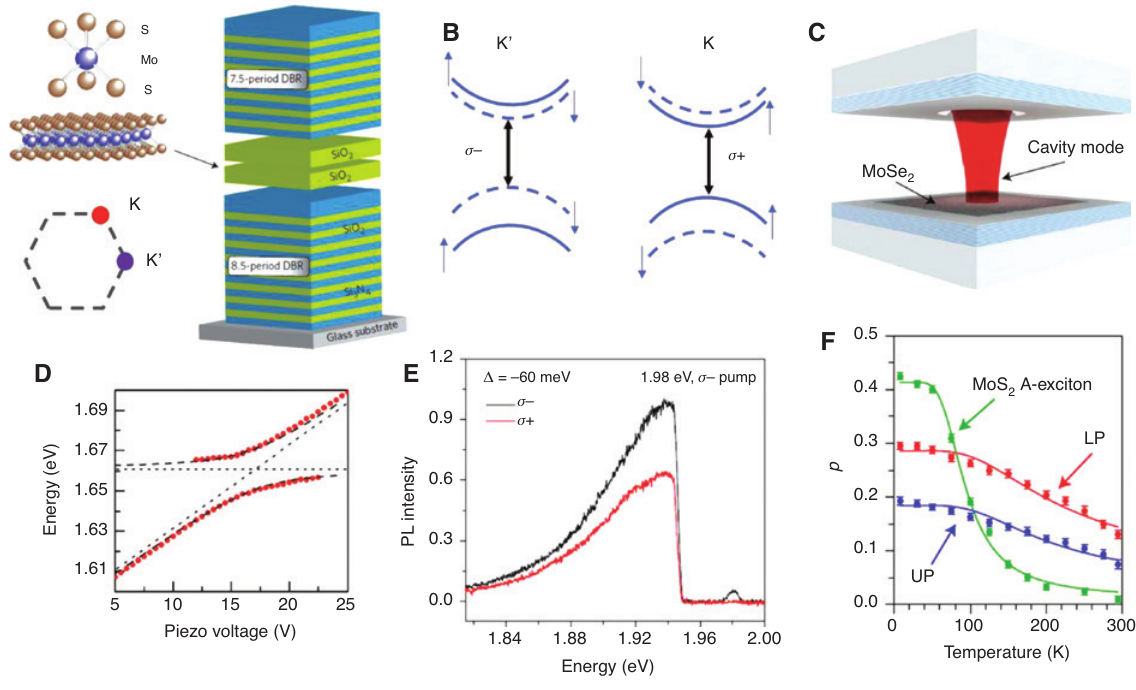
Figure 2: Polaritons in TMD MLs. (A) Sketch of a MoS ML inserted in a Fabry-Perot cavity and scheme of K and K ′ valleys at the corners of the hexagonal first Brillouin zone, 2 adapted from Ref. [35]. (B) Band diagram at the K and K ′ points for a MoS ML; the black arrows represent allowed optical transition, 2 showing the spin-valley locking effect. (C) Sketch of a tunable microcavity embedding a MoSe flake [36]. (D) Anticrossing of the upper 2 polariton branch (UP) and the lower polariton branch (LP) in the tunable microcavity of C; by modifying the voltage applied to the piezoelectric mirror, the energy of the cavity mode is modified [36]. (E) PL intensity of the σ+ and σ − polarized LP under non-resonant excitation with a σ − polarized pump; the pump polarization is partially retained by polaritons, which is a demonstration of the spin-valley locking for polaritons in TMD MLs. (F) Polarization degree as a function of temperature for MoS bare A-excitons, LP and UP; remarkably, at 2 high temperatures, valley polaritons are more effective than bare excitons in retaining valley polarization